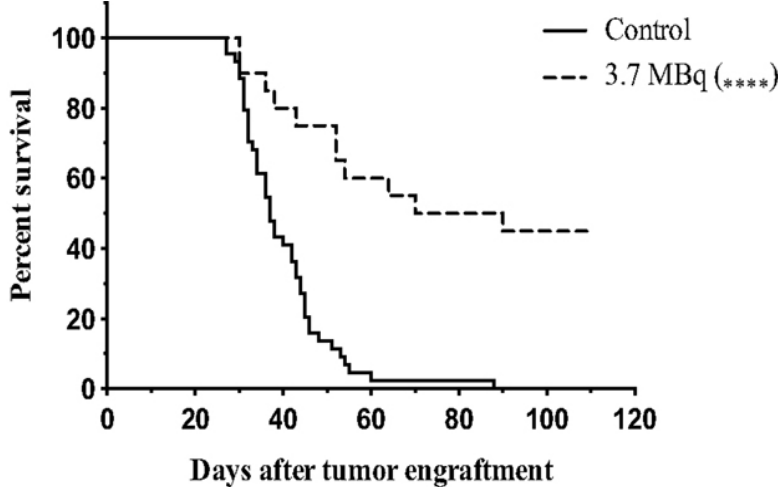
Figure 5. Survival curve of mice injected with 5T33 cells at day 0. 3.7 MBq of 213 Bi-9E7.4 antibodies was injected for alpha therapy ( n = 20), and NaCl was injected into the control group ( n = 44). Reproduced from [96], Frontiers,